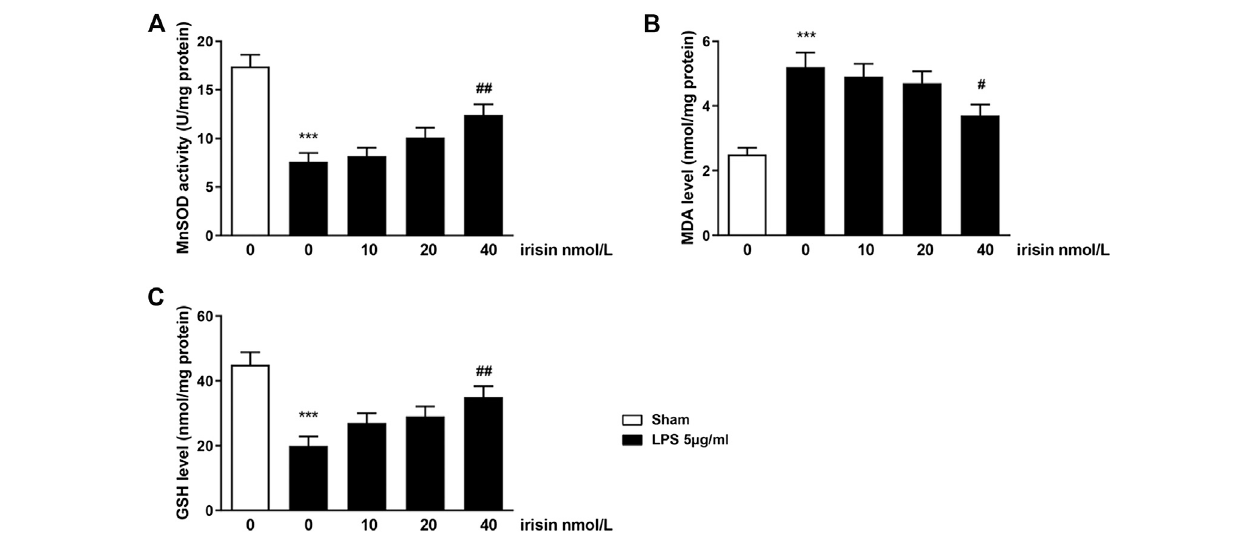
FIGURE 6 | Effects of irisin on Mn-superoxide dismutase (MnSOD) activity (A) , malondialdehyde (MDA) level (B) and glutathione level (C) in LPS-challenged PC12 cells (*** p (cid:2) 0.000066 and ## p (cid:2) 0.0073 for MnSOD activity; *** p (cid:2) 0.00028 and # p (cid:2) 0.023 for MDA level; *** p (cid:2) 0.00043 and ## p (cid:2) 0.0072 for GSH level). Data are presented as Mean ± SEM, n (cid:2) 5. *** p < 0.001 when compared with control group; # p < 0.05 and ## p < 0.01 when compared with LPS group.